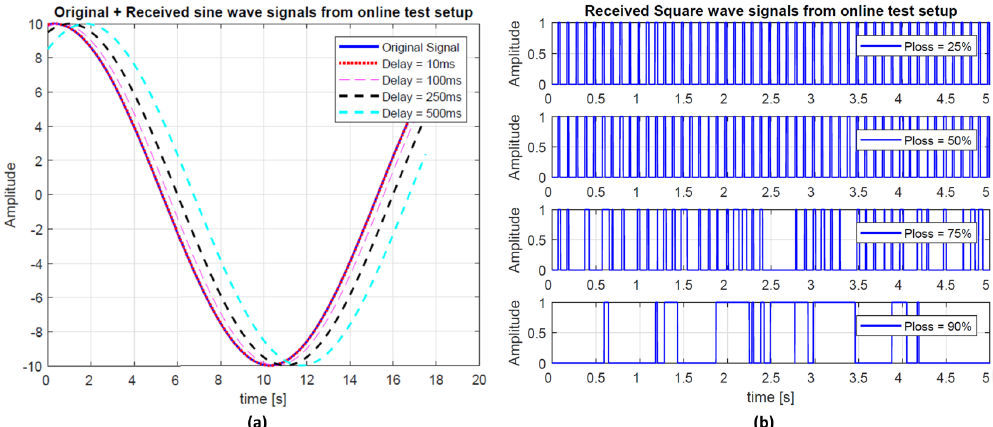
Figure 12. Test Results captured from RT setup showing received: ( a ) sine signals obtained through a network with four different average delay patterns; and ( b ) square wave signal obtained through a network with four different packet loss rates with MSE of around 5.0765 × 10 − 4 . Figure 13 captures the original sine wave with the ones received from non-RT as well as RT test setups (with average delay = 500 ms.) to show that the results obtained from both test setups are